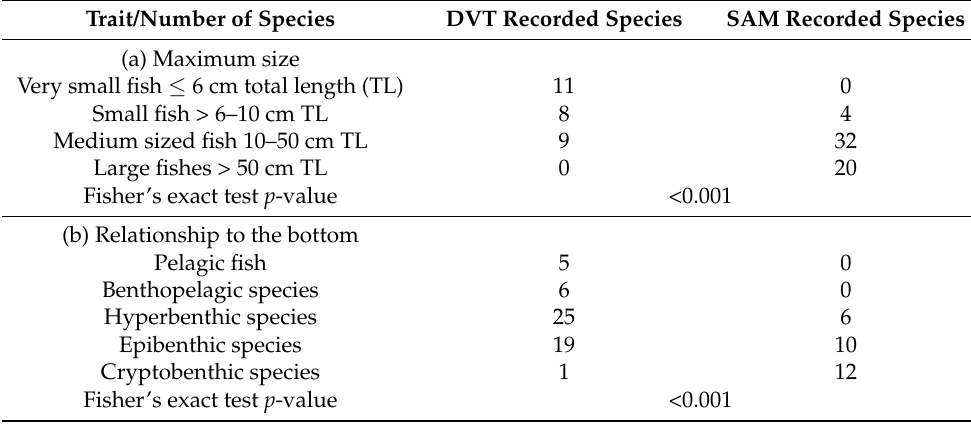
Table 3. The frequencies of species traits for species recorded by the DVT method and SAM. Trait/Number of Species DVT Recorded